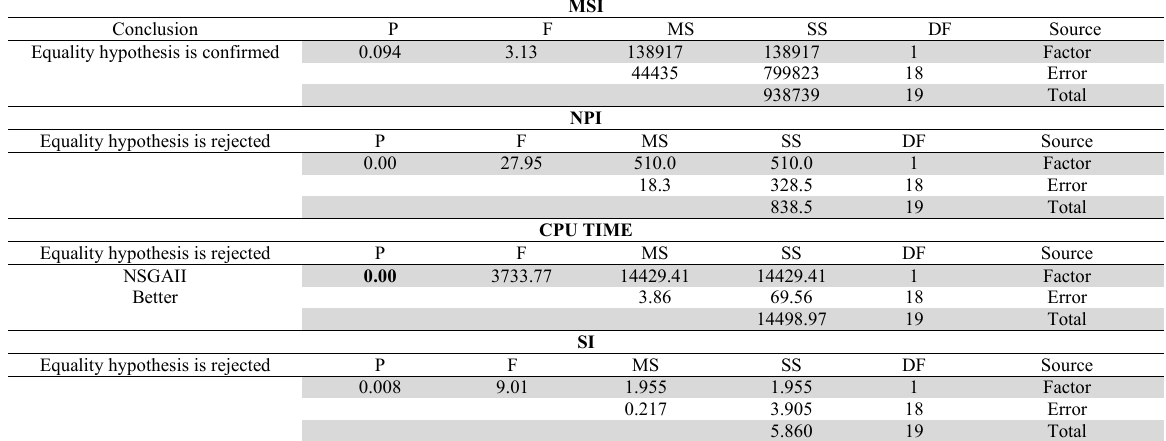
The summary of the results of one-way ANOVA test on NSGA II versus MOPSO for medium sizes